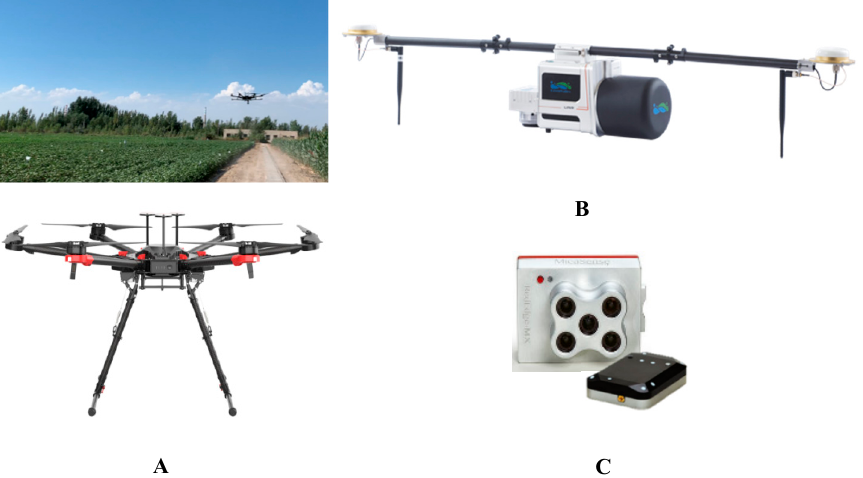
Figure 3. Two DJI Matrice 600 Pro UAV platforms used in this study: ( A ) DJI Matrice 600 Pro UAV; ( B ) LiAir 200; ( C ) Micasense RedEdge-M multispectral camera.